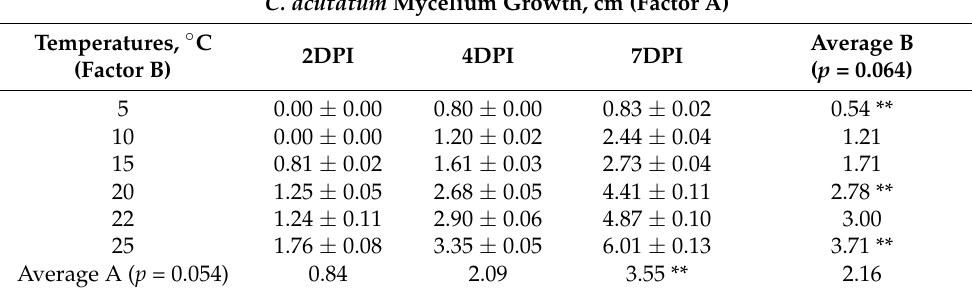
Table 6. Effect of temperature on C. acutatum mycelium growth after 2, 4 and 7 DPI. DPI–days